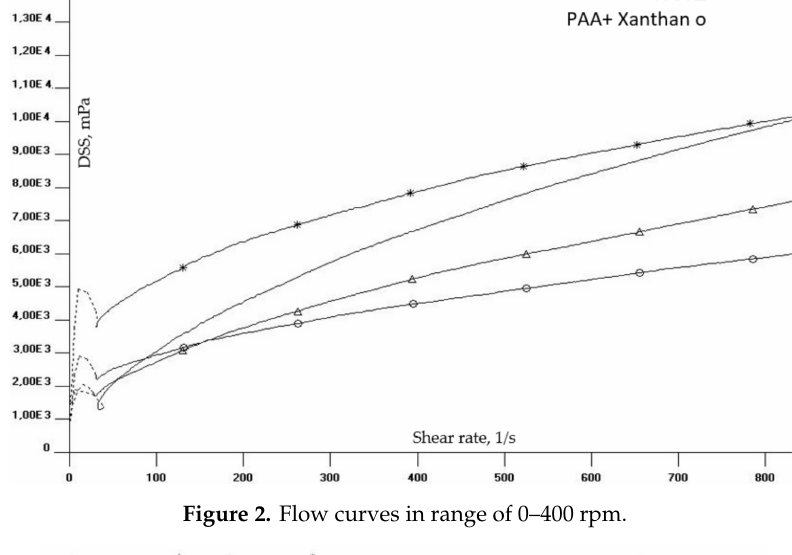
Figure 2. Flow curves in range of 0–400 rpm.